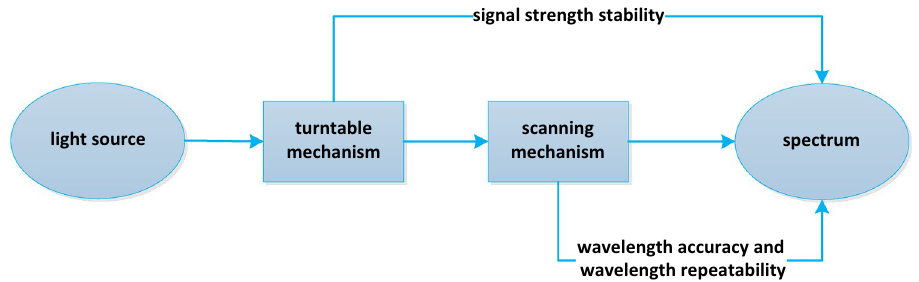
Figure 1. Schematic diagram of influencing